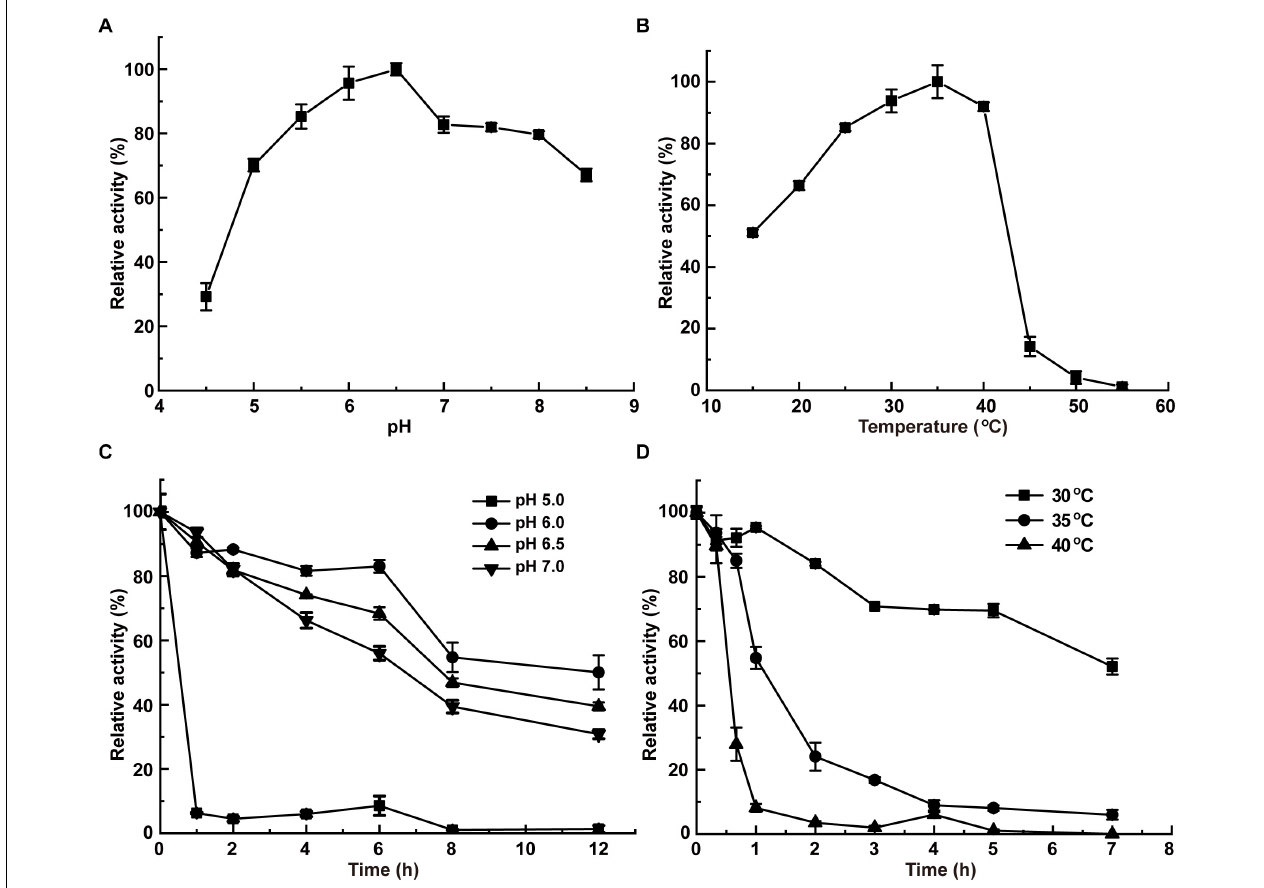
FIGURE 2 | Effects of pH and temperature on the activity and stability of InvDz13. (A) pH optimum. Samples were incubated at 35 ◦ C. (B) Temperature optimum. Samples were incubated at pH 5.0. (C) pH stabilities at pH 5.0, 6.0, 6.5, and 7.0, respectively. Samples were incubated at 30 ◦ C. (D) Thermostabilities at 30, 35, and 40 ◦ C, respectively. Samples were incubated at pH 6.5. Standard deviations and values were calculated from triplicate technical repeats of